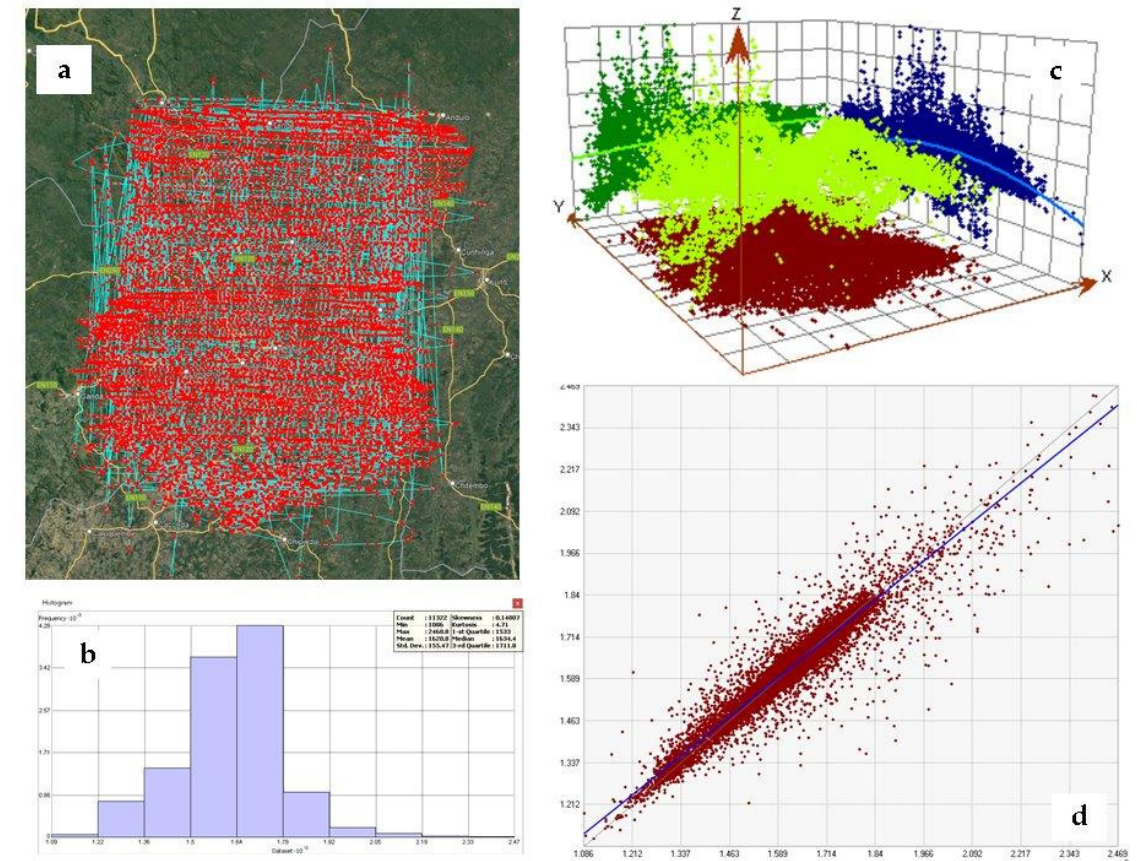
Figure 3. Illustrations of different steps of DEM preparation: ( a ) created path in Google Earth Pro, ( b ) histogram of values, ( c ) trend analysis tool, ( d ) scatterplot of observed elevation vs. estimated elevation.